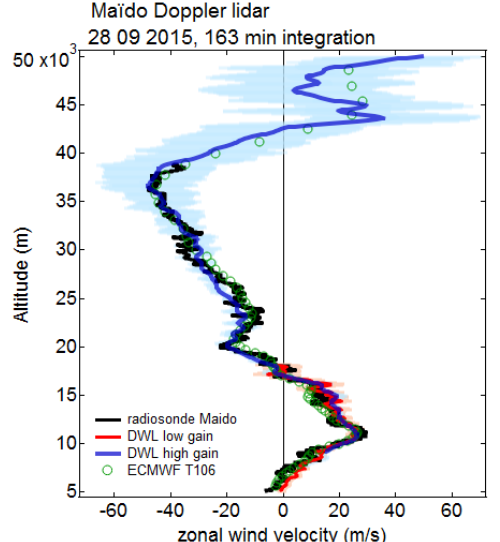
Figure 1. Comparison of zonal wind profiles obtained using Maido Doppler wind lidar on 28.09.2015 with collocated radiosounding and ECMWF operational analysis. Shaded areas indicate the total error of lidar